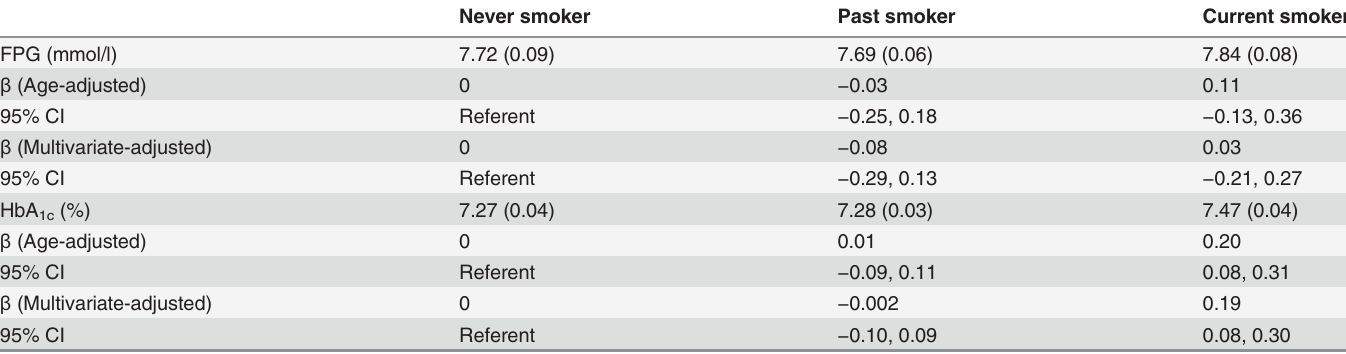
Table 2. Age-adjusted mean values and multivariate-adjusted partial regression coefficients (95% CIs) of FPG and HbA 1c according to smoking status.